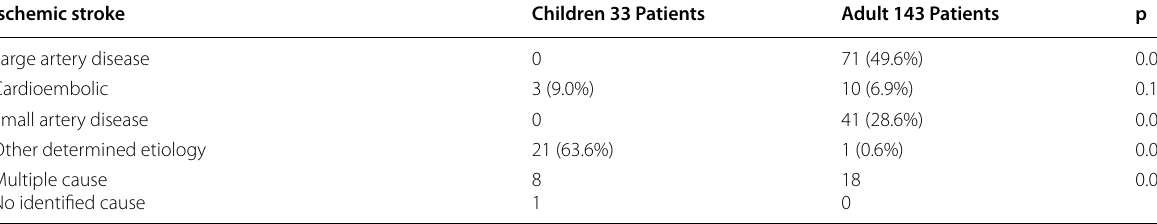
By Chi square test and Fisher exact test, *p value was significant